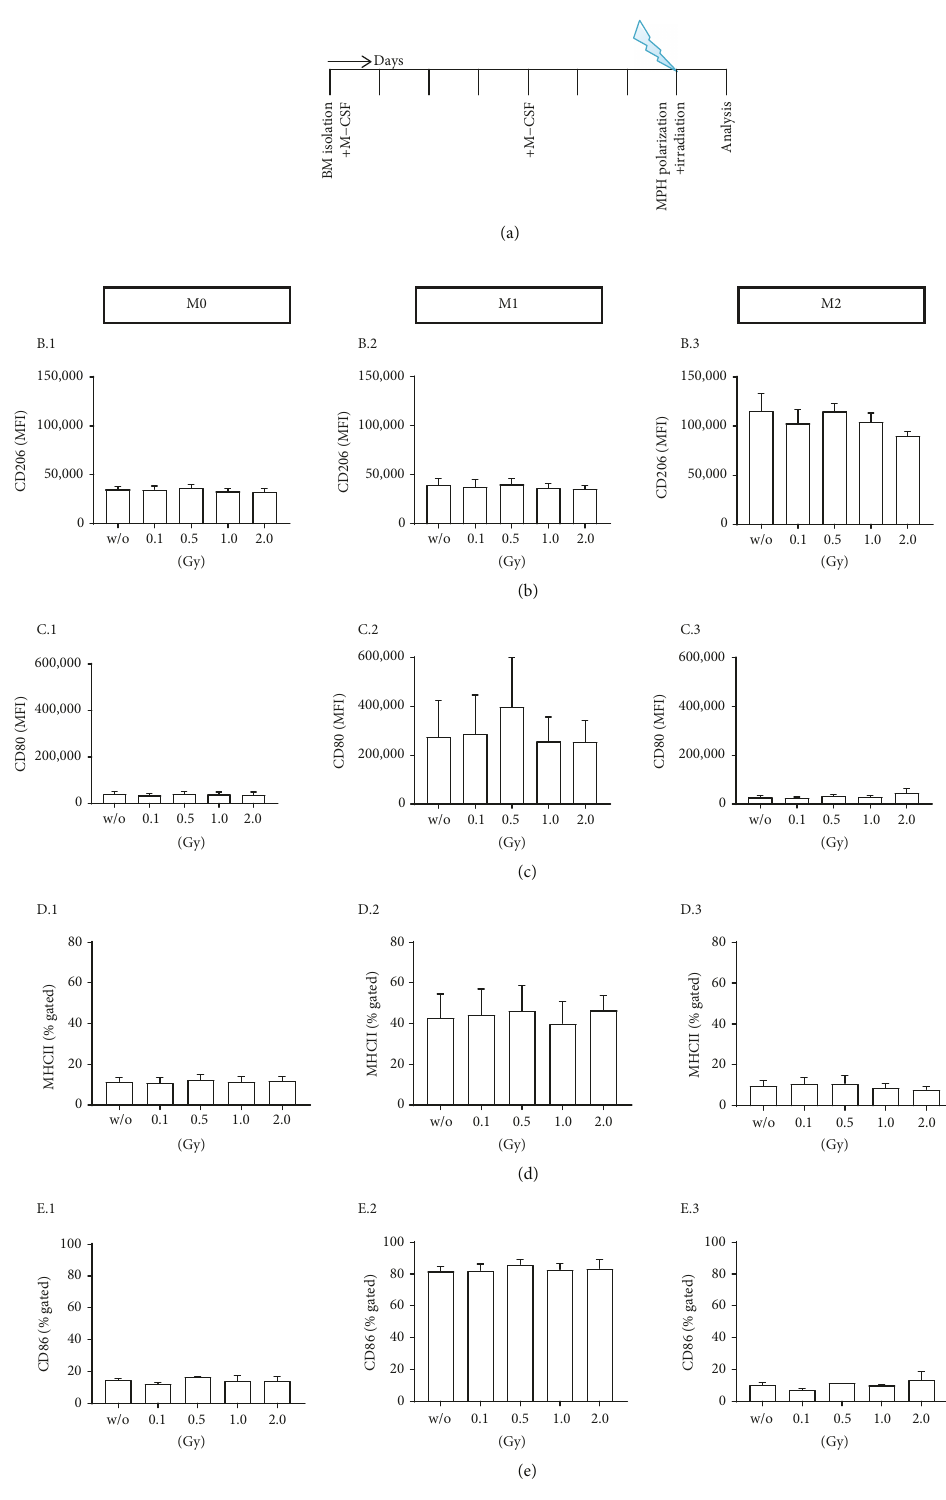
Figure 2: Low-dose radiotherapy has no in fl uence on macrophage polarization. h TNF- α tg bone marrow was isolated and di ff erentiated into M0 macrophages according to the experimental set-up shown in (a). 24 h prior to the characterization of the macrophage phenotypes, cells were treated with three di ff erent polarization cocktails (M0: 5 ng/ml M-CSF; M1: 4ng/ml M-CSF, 20ng/ml IFN- γ , and 20ng/ml LPS; M2: 5ng/ml M-CSF and 20ng/ml IL-4). 2 h after this stimulation, cells were irradiated with the indicated dose. Macrophages showed characteristic surface marker expression after polarization such as CD206 ((b) B.1 – B.3) for M2 and CD80 ((c) C.1 – C.3), MHCII ((d) D.1 – D.3), and CD86 ((e) E.1 – E.3) for M1. No signi fi cant di ff erences of the surface marker expression were found in dependence of irradiation and irradiation doses. Depicted is data from three independent experiments. Data is presented as mean mean ± SEM